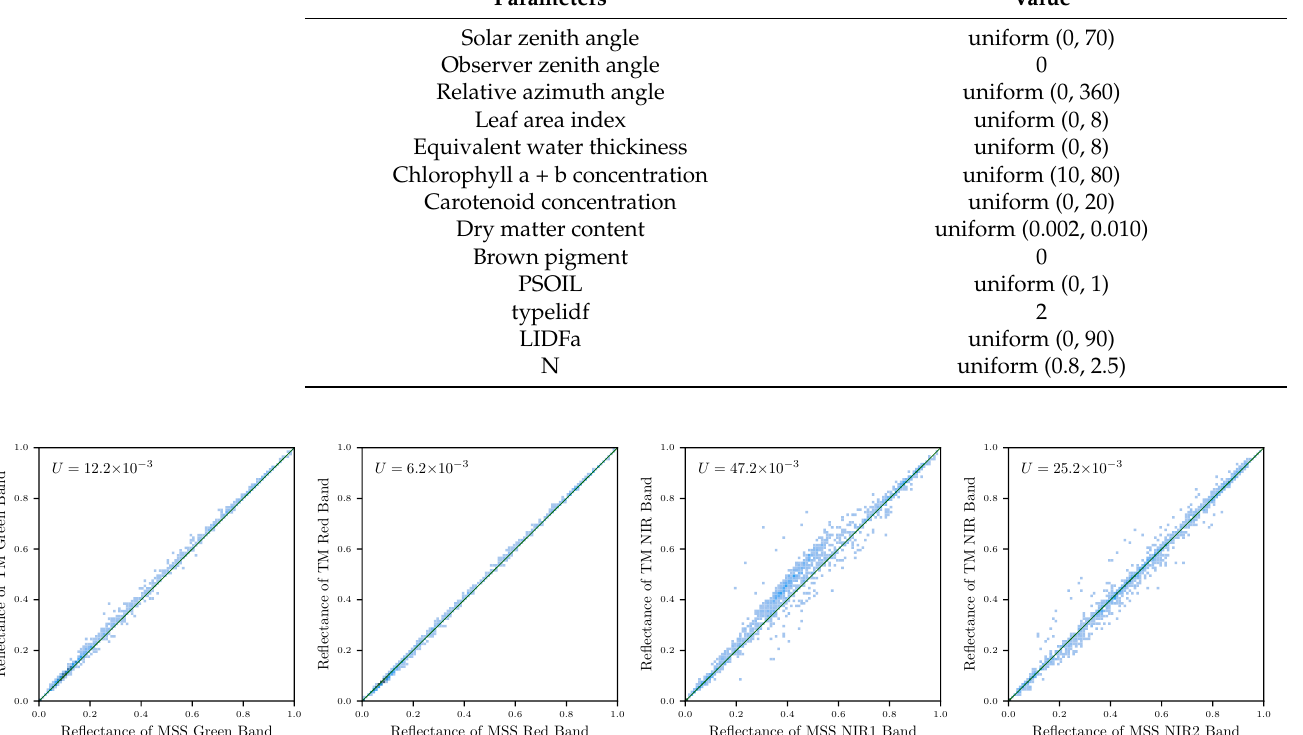
Figure 4. ECOSTRESS effective reflectance comparison of Landsat 5 MSS and TM.